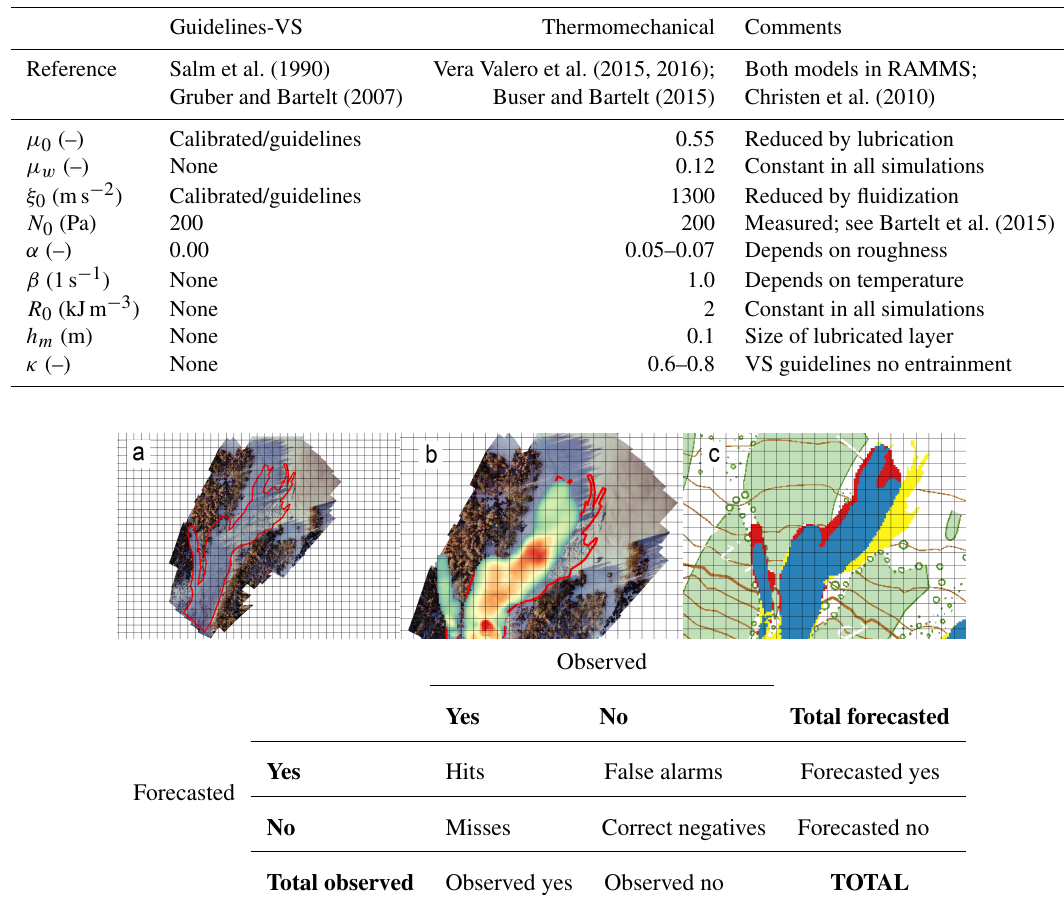
Figure 2. Method to construct the contingency table, based on measured deposits outline (a) , which is then combined with the simulated deposit area (b) to identify hits (blue), false alarm (red), misses (yellow) and correct negatives (no color, map only) (c)